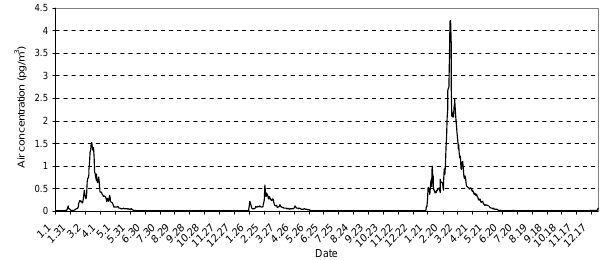
Fig. 2 Fig. 2. MEDIA modeled mean daily air concentration (pgm − 3 ) of